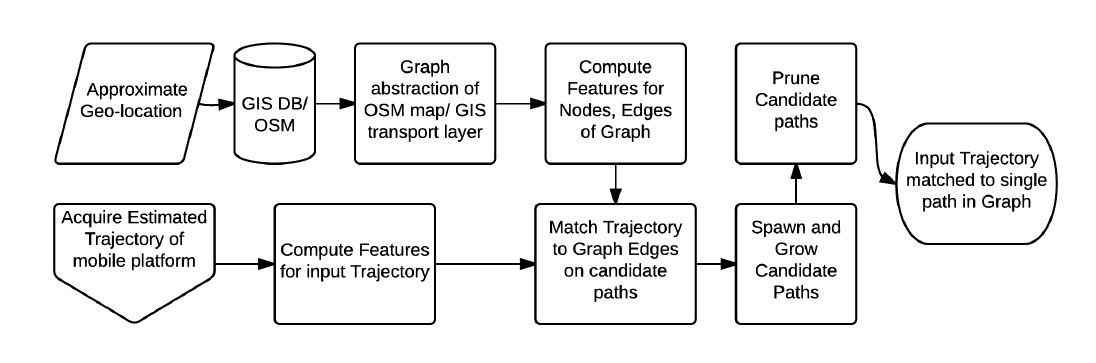
Figure 1: Mobile Trajectory Geo-Localization: VO is used to compute a trajectory in real-time which is abstracted as a sub-graph and is progressively localized by sub-graph matching in a graph abstraction of transport network map of the region of interest.